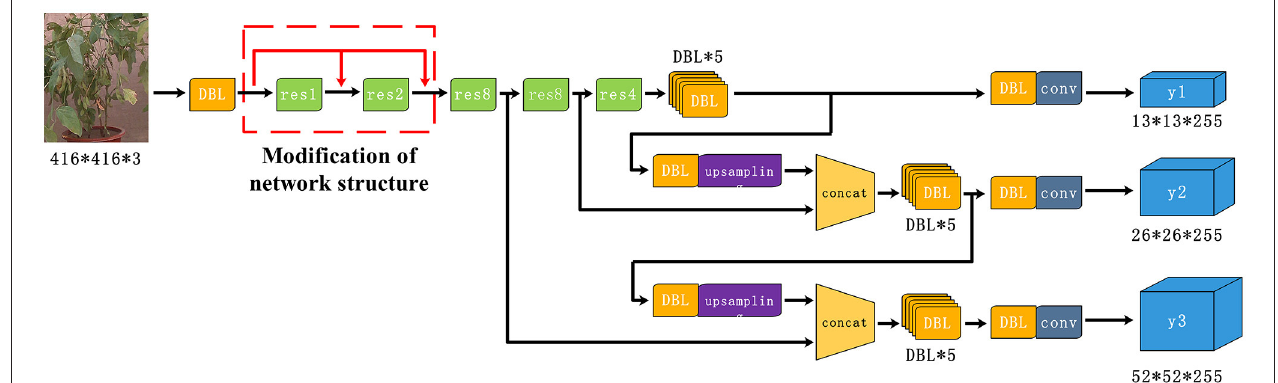
FIGURE 4 | Improved YOLOv3 for soybean leaves, pod, and type